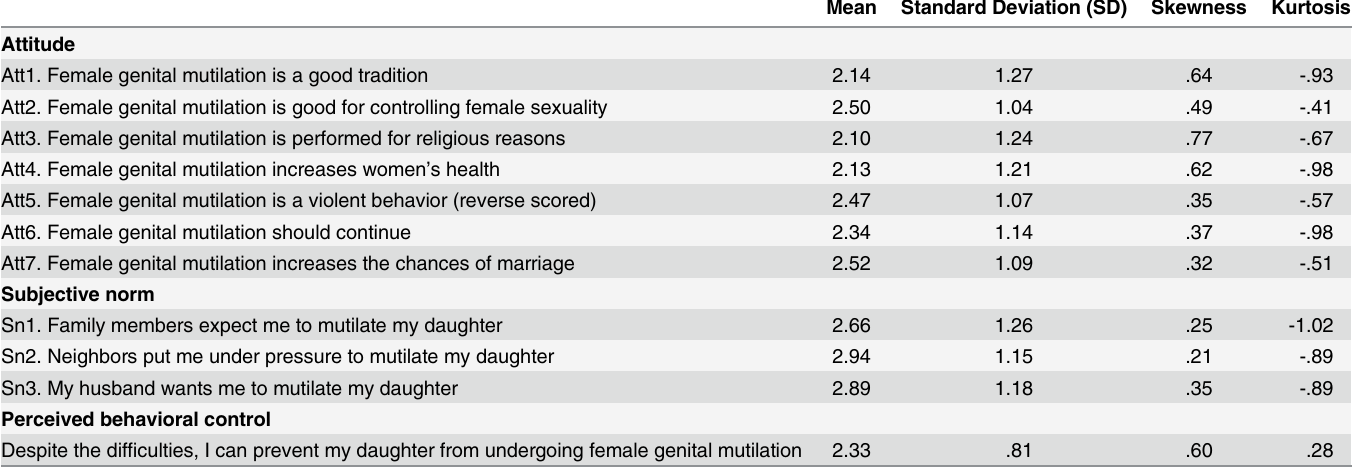
Table 1. Descriptions of the